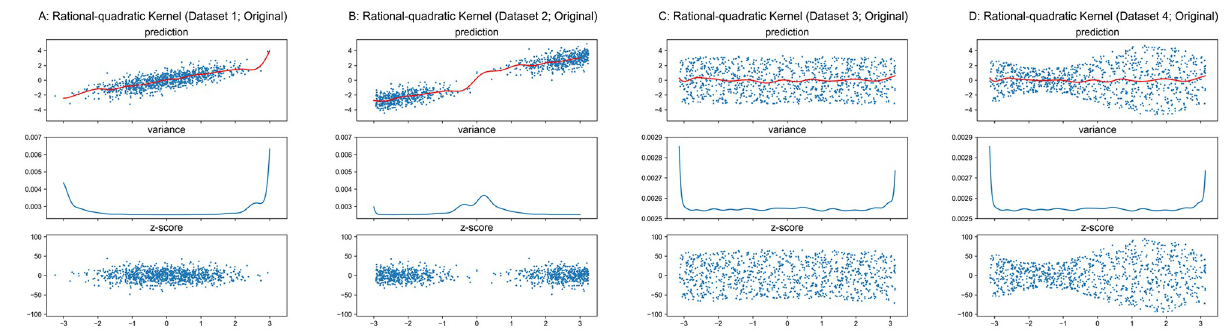
Fig 10. GPR with Rational-Quadratic kernel on original datasets. Scales of Y-axis for variance plots are different.